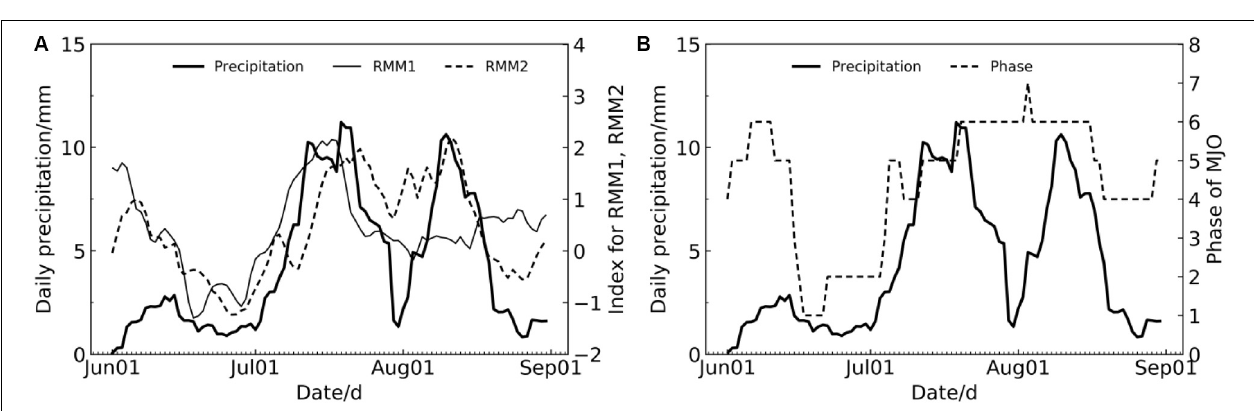
FIGURE 3 | Daily variation of precipitation in North China (heavy line) and RMM1 ( A , fine solid line), RMM2 ( A , dashed line), phase ( B , dashed line) of MJO in the summer of